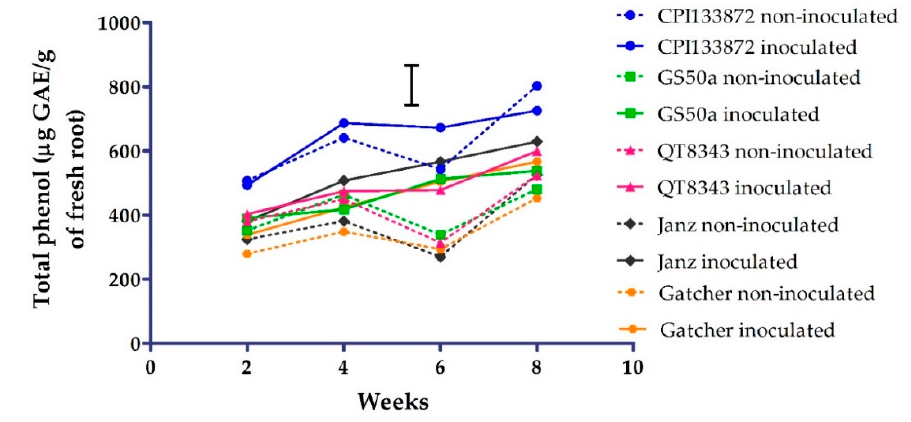
Figure 1. Total phenols ( µ g gallic acid equivalent (GAE) / g of fresh root) from 2–8 weeks in the roots of Pratylenchus thornei inoculated (solid line) and non-inoculated (dotted line) resistant wheat genotypes—CPI133872 (blue), GS50a (green), and QT8343 (red)—and susceptible wheat genotypes—Janz (black) and Gatcher (orange). The values are the means of three replicates. The bar marker indicates the least significant di ff erences (LSD) = 154 ( p = 0.05) for the interaction genotype* P. thornei * time.